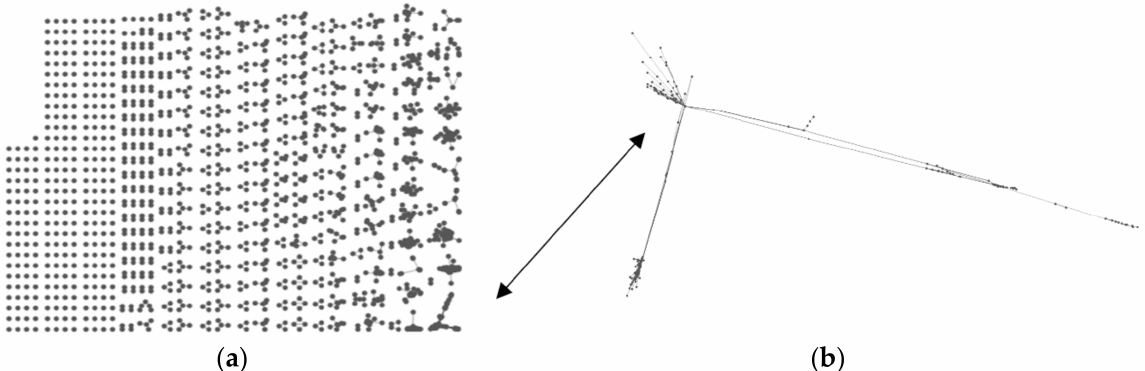
Figure 8. The implemented dataset with the highest centralization value. The total number of nodes of this dataset, shown in ( a ), is 7884. The largest and most centralized cluster, shown in ( b ), is formed around CNN’s official Twitter account as the central node and has 5886